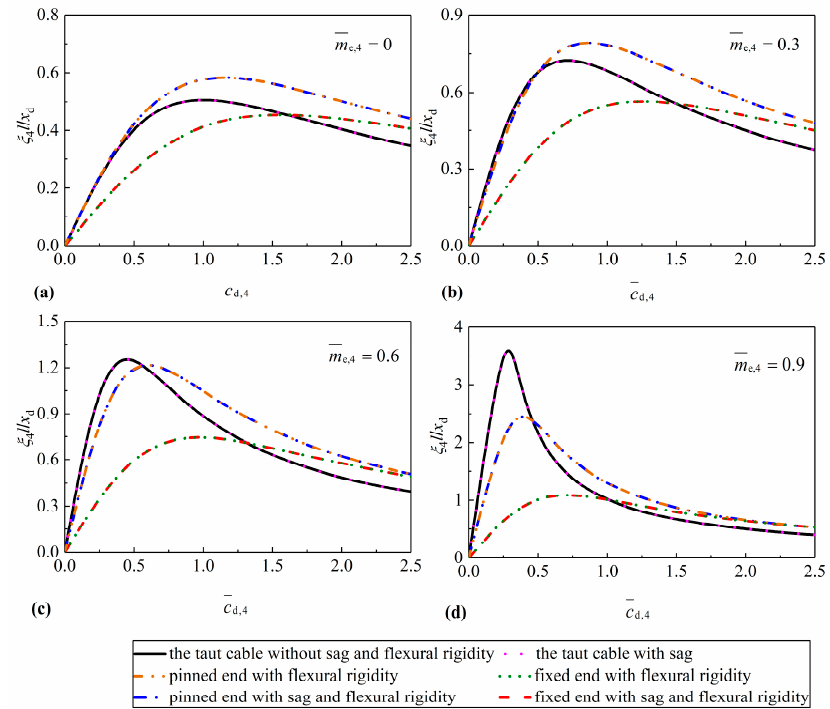
Figure 11. The fourth supplemental modal damping ratio of the medium cable versus damping coe ffi cient for various inertial masses: ( a ) m e,4 = 0; ( b ) m e,4 = 0.3; ( c ) m e,4 = 0.6; ( d ) m e,4 = 0.9.